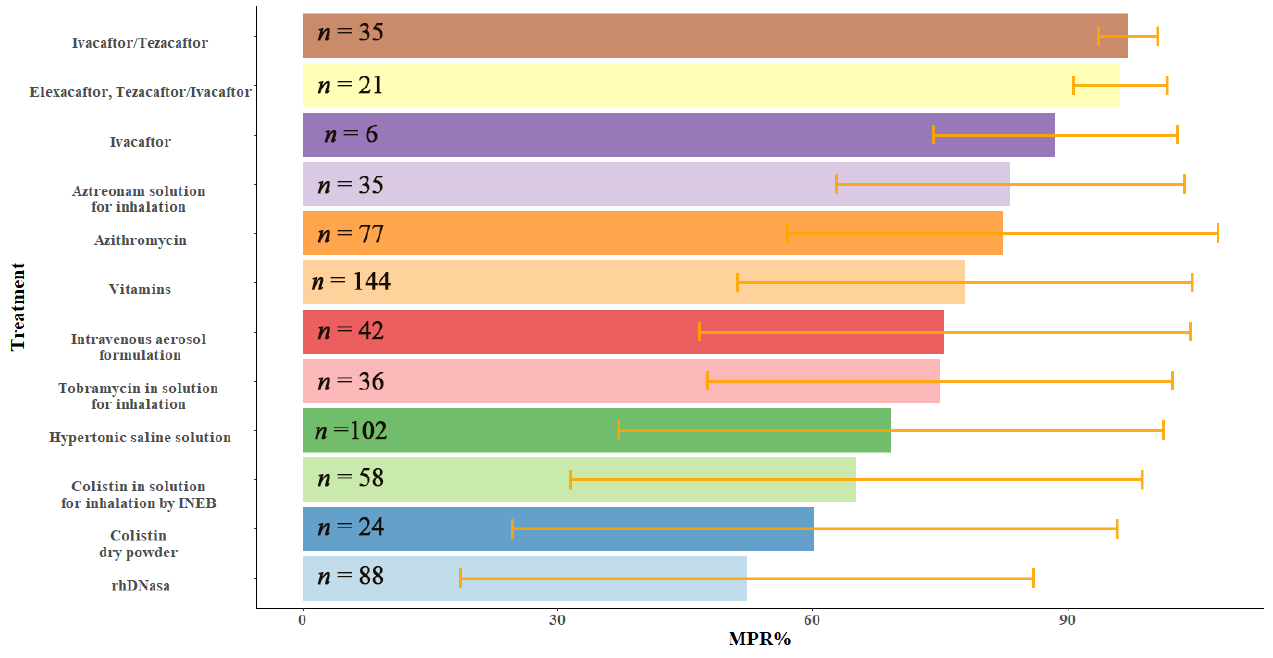
Figure 2. Compliance was measured by % of MPR for each treatment, ranked from highest to lowest mean %MPR. Bars and whiskers represent the mean value and the standard deviation of MPR % for each treatment. The sample size of each treatment appears inside the bar.